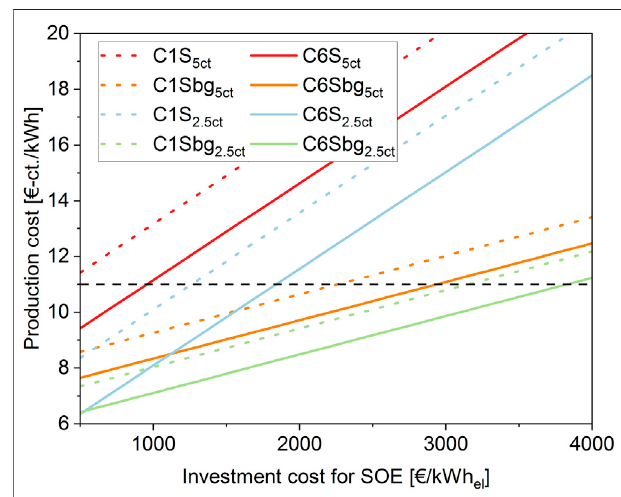
FIGURE 9 | Production cost in € -ct/kWh biomethane of the SOE-based processes as a function of investment cost for the SOE stack. Two different electricity prices are considered: 5 € -ct/kWh el and 2.5 € -ct/kWh el